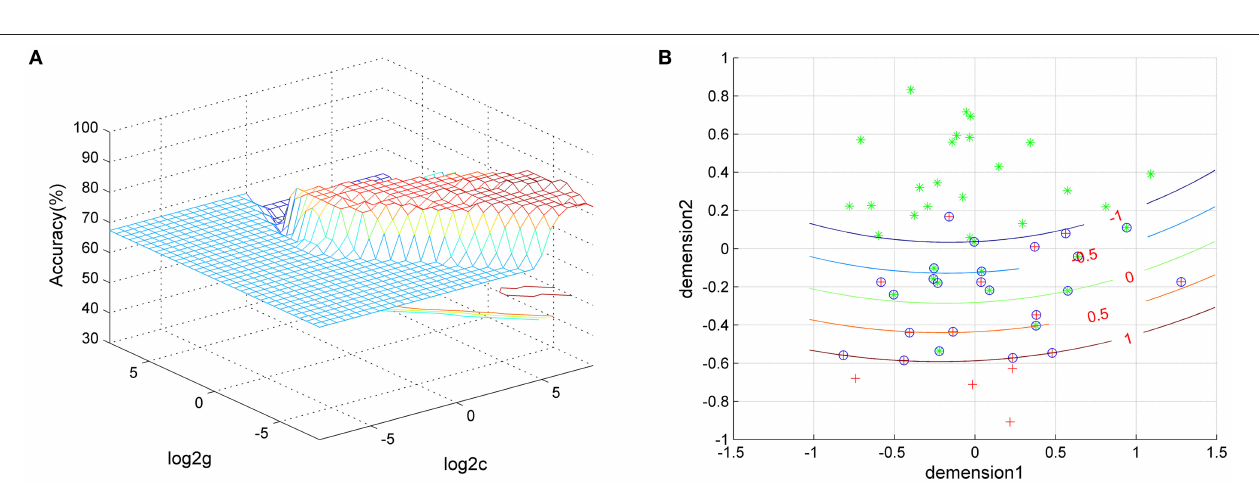
FIGURE 5 | Correlations between abnormal fALFF and clinical variables. For all MDD patients, a negative correlation was found between the scores of weight loss in HRSD-17 and the fALFF of the left superior MPFC (A) . The severity of GI symptoms was found positively correlated with the fALFF values of the right superior frontal gyrus/middle frontal gyrus (B) and negatively correlated with the fALFF values of the left superior MPFC (C) . fALFF , fractional amplitude of low-frequency fluctuation; MDD , major depressive disorder; HRSD-17 , 17-item Hamilton Rating Scale for Depression; MPFC , medial prefrontal cortex.